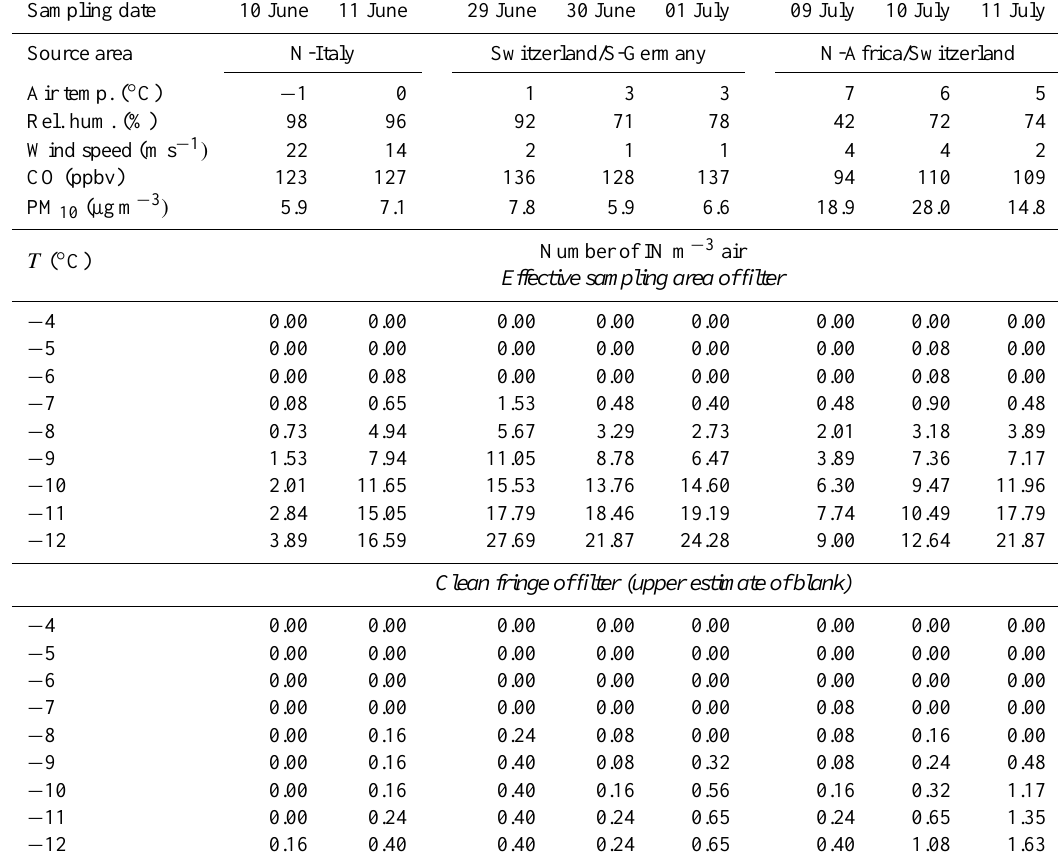
Table 1. Data on PM 10 filters analysed and number of ice nucleators detected (m − 3 )